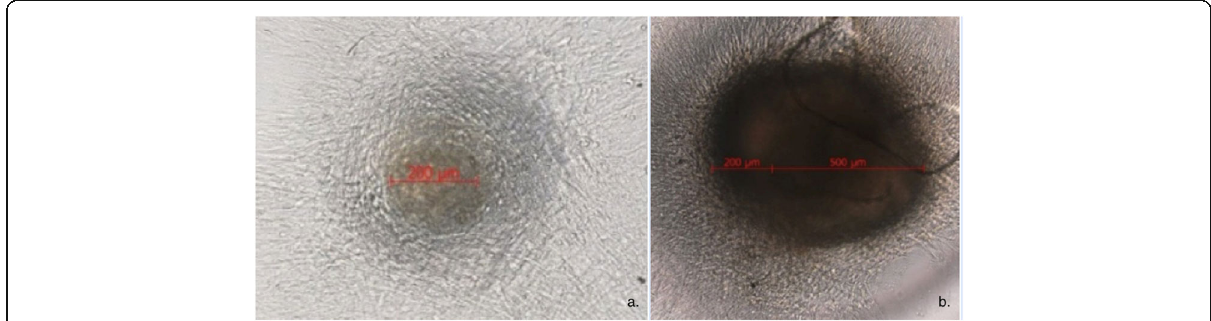
Fig. 4 Human Mesenchymal Stem Cells at 7-day culture forming nodules on uncoated glass ( a ) and tantalum-coated glass ( b )